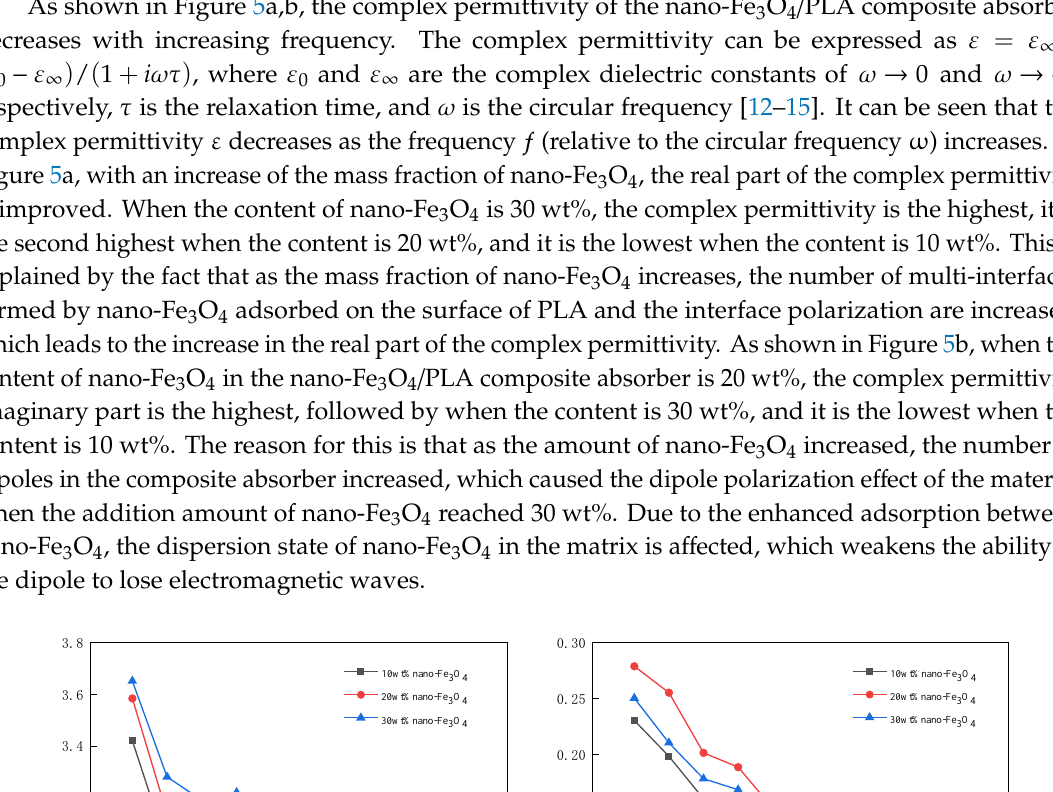
Figure 4. Reflection loss of nano-Fe 3 O 4 /PLA composite absorbers with different nano-Fe 3 O 4 co ntent.